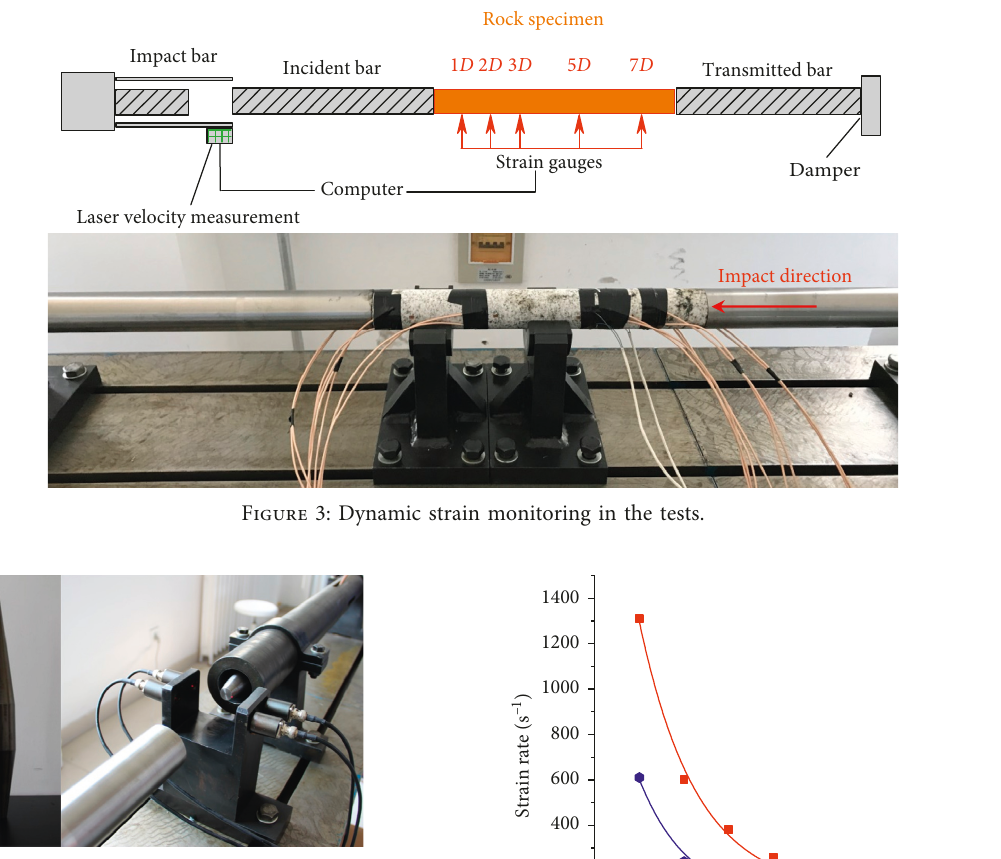
Figure 4: Fusiform bullet used in the tests.